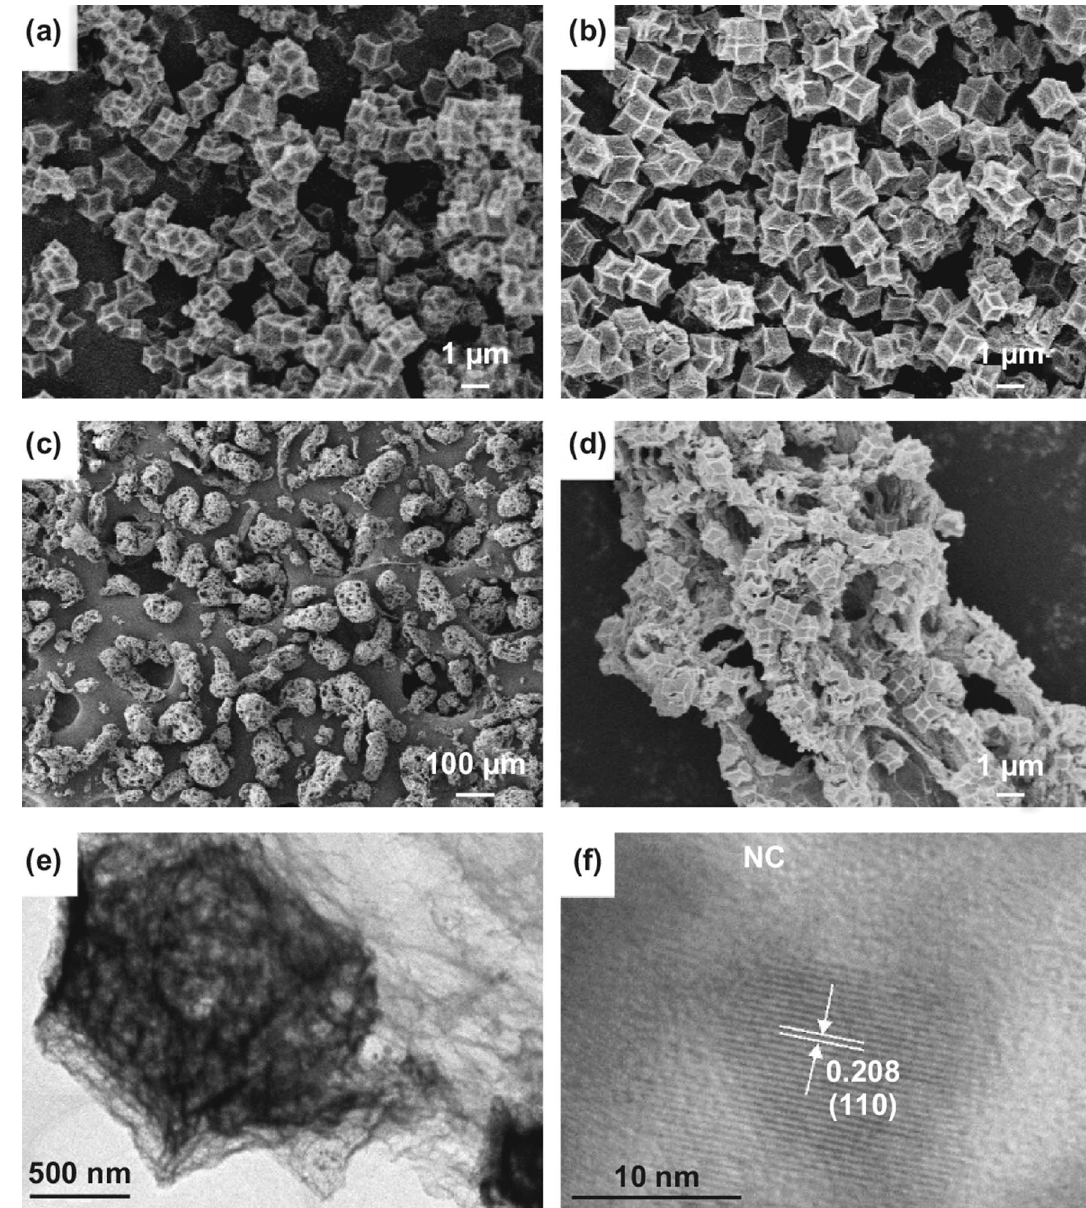
Fig. 2 FESEM images of a Co/NC, b Fe–Co/NC, c , d Fe–Co/NC/rGO, and e , f HRTEM images of the